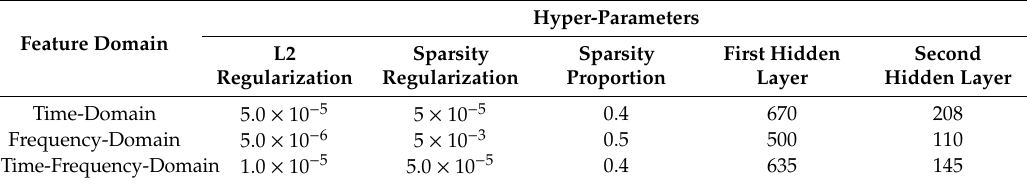
Table 1. Parameter used in a stacked-SAEs-based DNN for vibration signals.